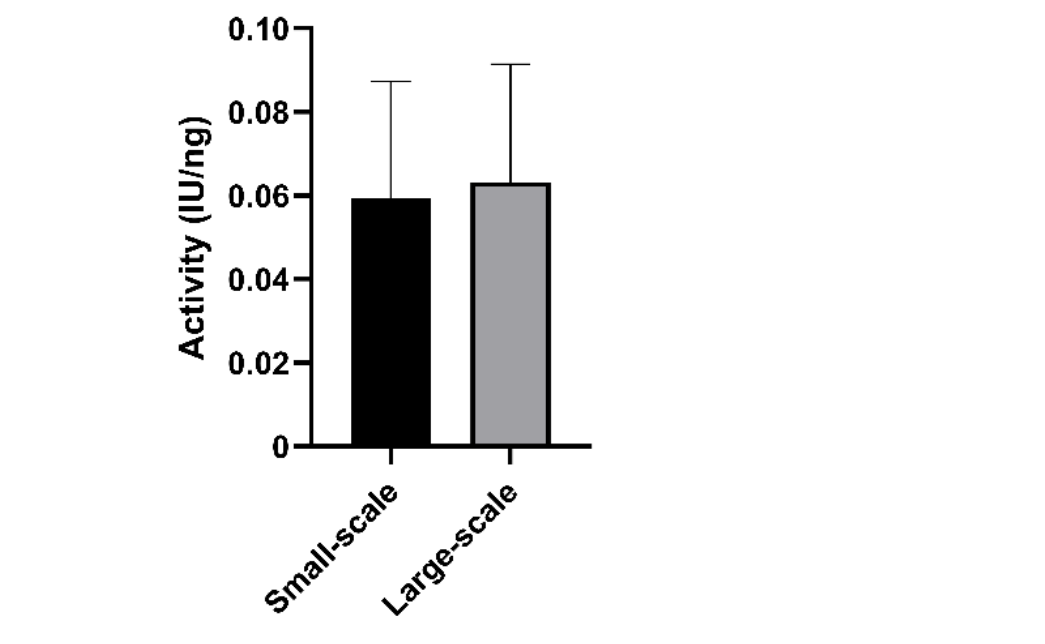
Figure 6. Activity of rADAMTS13 from small-scale V5-affinity purification and two-step large-scale purification, as measured by FRETS-VWF73 activity assay and normalized to the amount of protein analyzed (ng), n = 3.